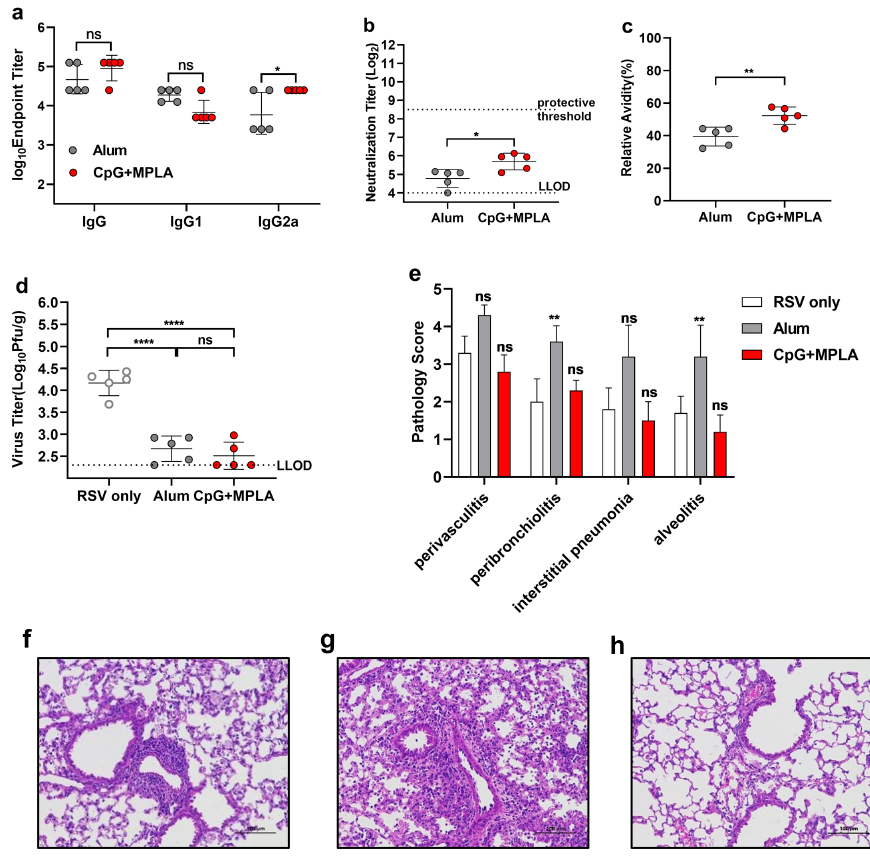
Figure 7. CpG + MPLA adjuvanted opti-FI-RSV avoids the risk of ERD caused by suboptimal immunization. Female cotton rats (n = 5 per group) were injected intramuscularly with opti-FI-RSV combined with a Th2-biasing adjuvant (Alum) or a Th1-biasing adjuvant combination (CpG + MPLA) in a prime-boost regimen at week 0 and week 3. Animals were challenged with the RSV A2 strain intranasally at a titer of 1 × 10 6 PFU on day 49. ( a ) Pre-F specific IgG, isotype IgG1 and IgG2a serum antibodies were determined at 2 weeks after boosting. ( b ) Serum neutralizing antibody titers were measured using RSV A2 as described in the Materials and Methods. ( c ) IgG avidity against pre-F after a 7 M urea wash was determined at 2 weeks after boosting. ( d ) RSV virus titers were determined in the right lung homogenate of cotton rats at day 5 after challenge as determined by PFU. ( e ) Left lungs were harvested at day 5 after challenge, and histopathology scoring was performed. ( f – h ) Representative H&E staining images are shown. ( a , b , d ) The symbols indicate individual rats, the bars/lines indicate the geometric mean ± geometric SD, and the dotted lines indicate the lower limit of detection and the protective threshold. ( c ) The symbols indicate individual rats, and the bars/lines indicate the mean ± SD. ( e ) The bars/lines indicate the mean ± SD. The data were analyzed by ( a – c ) t test and, ( d ) one-way ANOVA followed by Tukey’s multiple comparisons post hoc test and ( e ) Kruskal-Wallis test (nonparametric) to analyze the differences between vaccination groups. The adjusted p values are shown by asterisks (ns = not significant; * p < 0.05; ** p < 0.01; **** p <